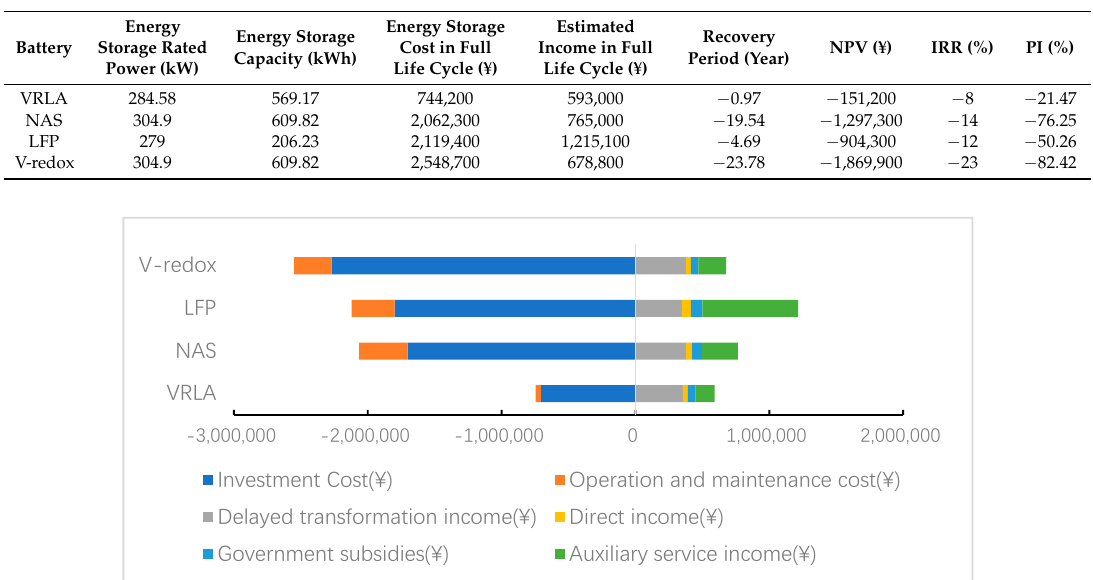
Table 5. Energy storage configuration and economic evaluation results of load peak shaving.